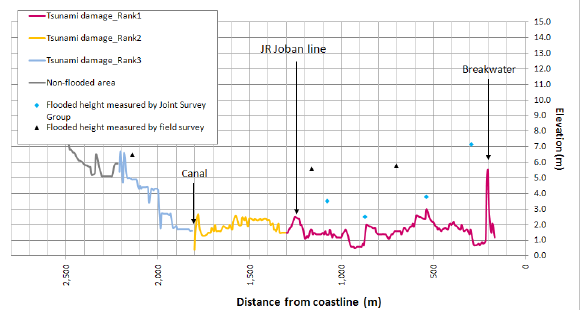
Figure 14. Cross section along EW direction of ground surface and tsunami flood depth on profile E (Takase, Yamamoto